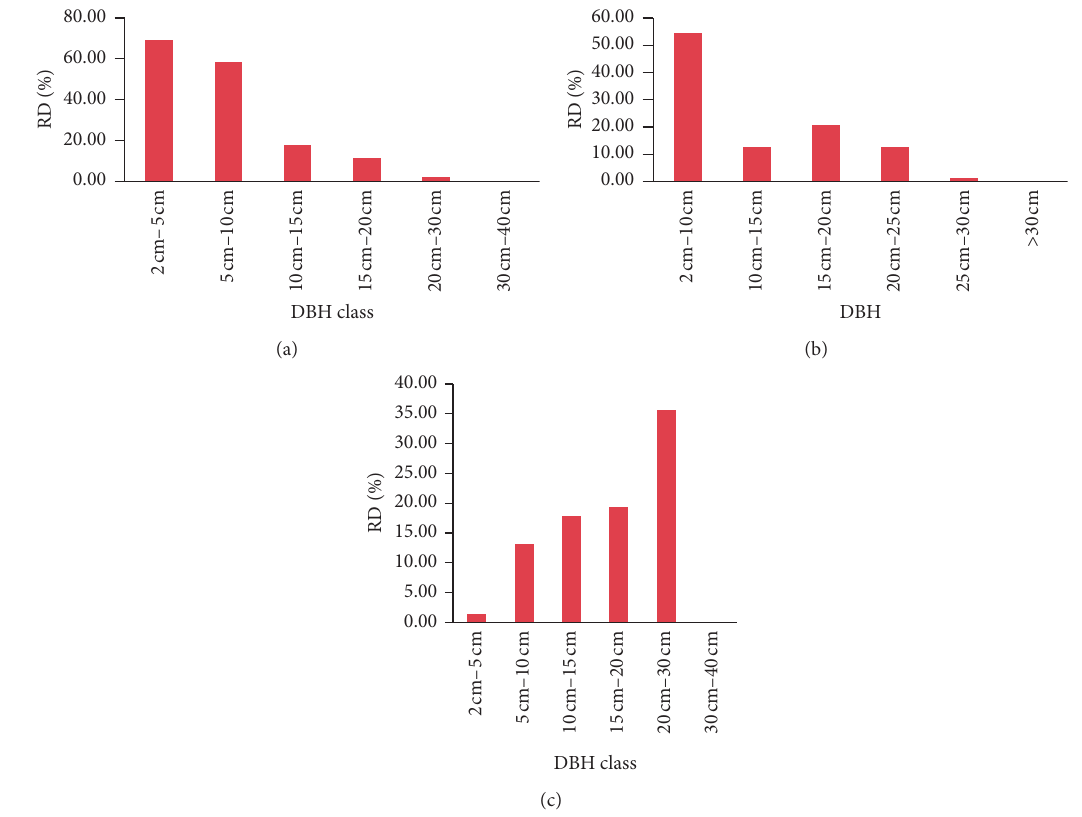
Figure 6: DBH class distribution of some important woody species in protected woodlands. 0 � < 2cm; 1 � 2–5cm; 2 � 5–10cm; 3 � 10–15 cm; 4 � 15–20cm; 5 � 20–25 cm; 6 � 25–30cm; 7 � > 30cm. (a) Acacia tortilis in PW. (b) Dichrostachys cinerea . (c) Acacia gerrardii